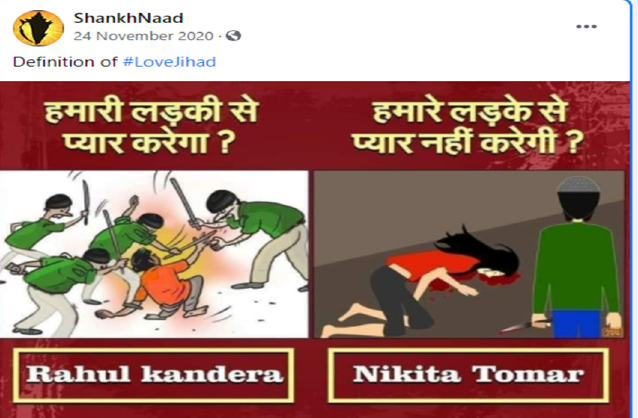
Figure 16. Facebook post of ShankhNaad a popular Hindu right-wing account on pictorial depiction of love jihad, shows the fate of Hindu man in saffron if he dares to love a Muslim girl ( left ), on ( right ) fate of Hindu woman dressed if she rejects Muslim man.